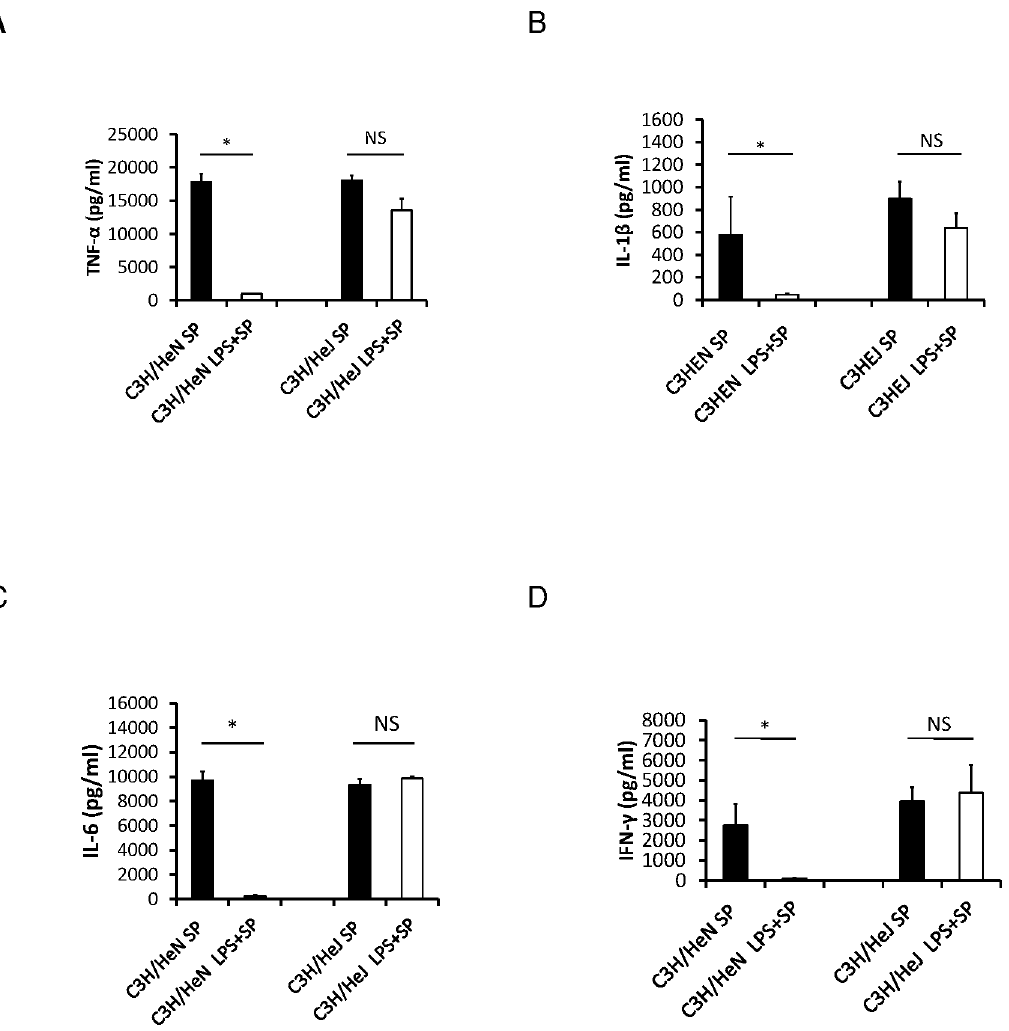
Figure 6. Serum concentrations of (A) TNF- a , (B) IL-1 b , (C) IL-6, and (D) IFN- c at 6 hours after bacterial challenge in LPS pretreated and PBS pretreated control C3H/HeN and C3H/HeJ mice (n=5 per group), *t-test, p ,